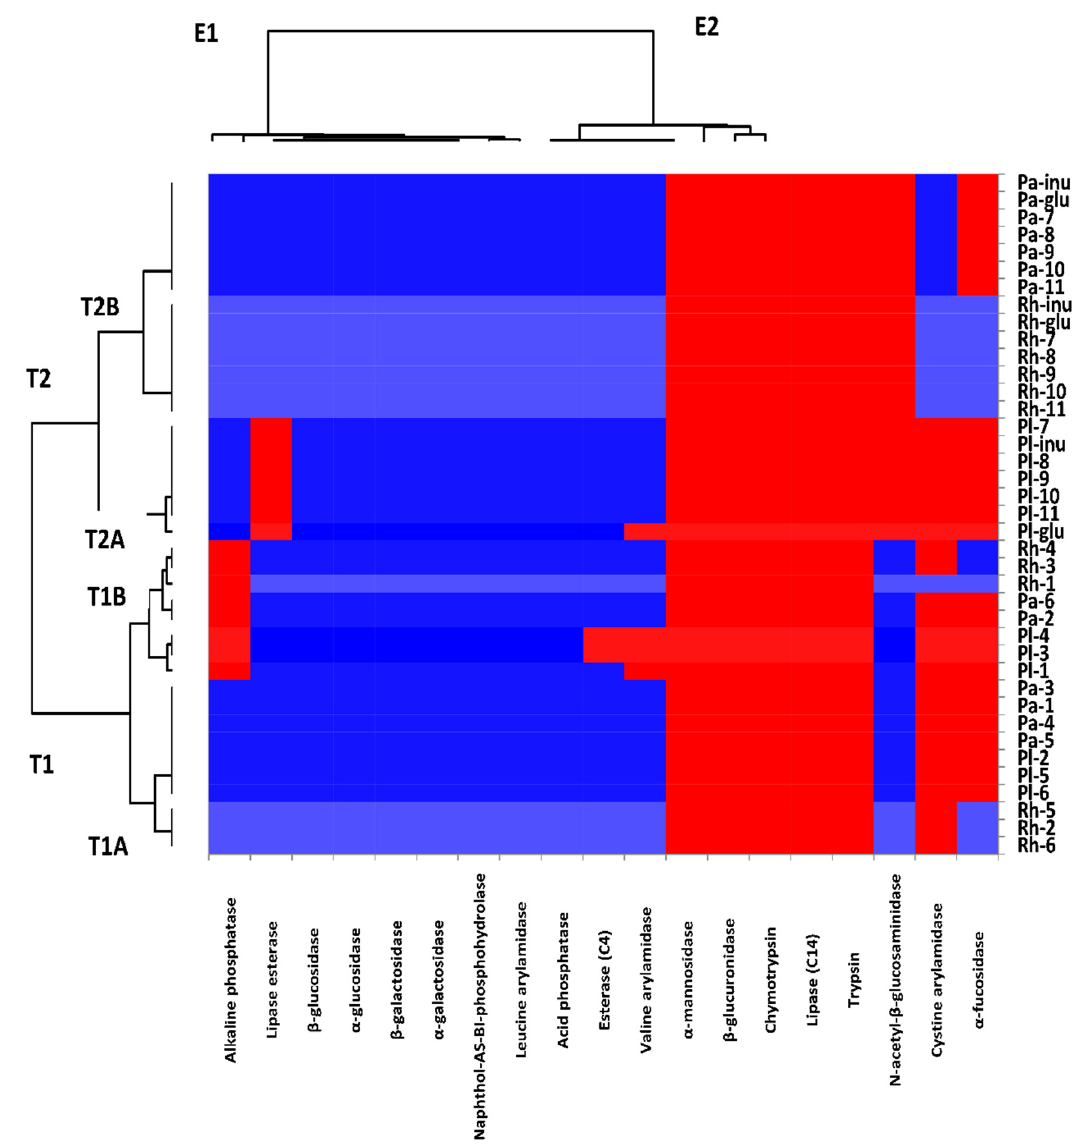
Figure 4. Heat map presenting the enzymatic profiles of the selected probiotic strains in relation to isolated phenolic compounds ( 1 – 10 ) or methanol extract. Glu and inu indicate glucose (positive con- trol) and inulin (prebiotic standard), respectively. Rh, Pa, and Pl indicate Lb. rhamnosus , Lb. paracasei , and Lb. plantarum . Red and blue, respectively, indicate a lack of enzyme activity or a positive reaction of the enzymatic profile.